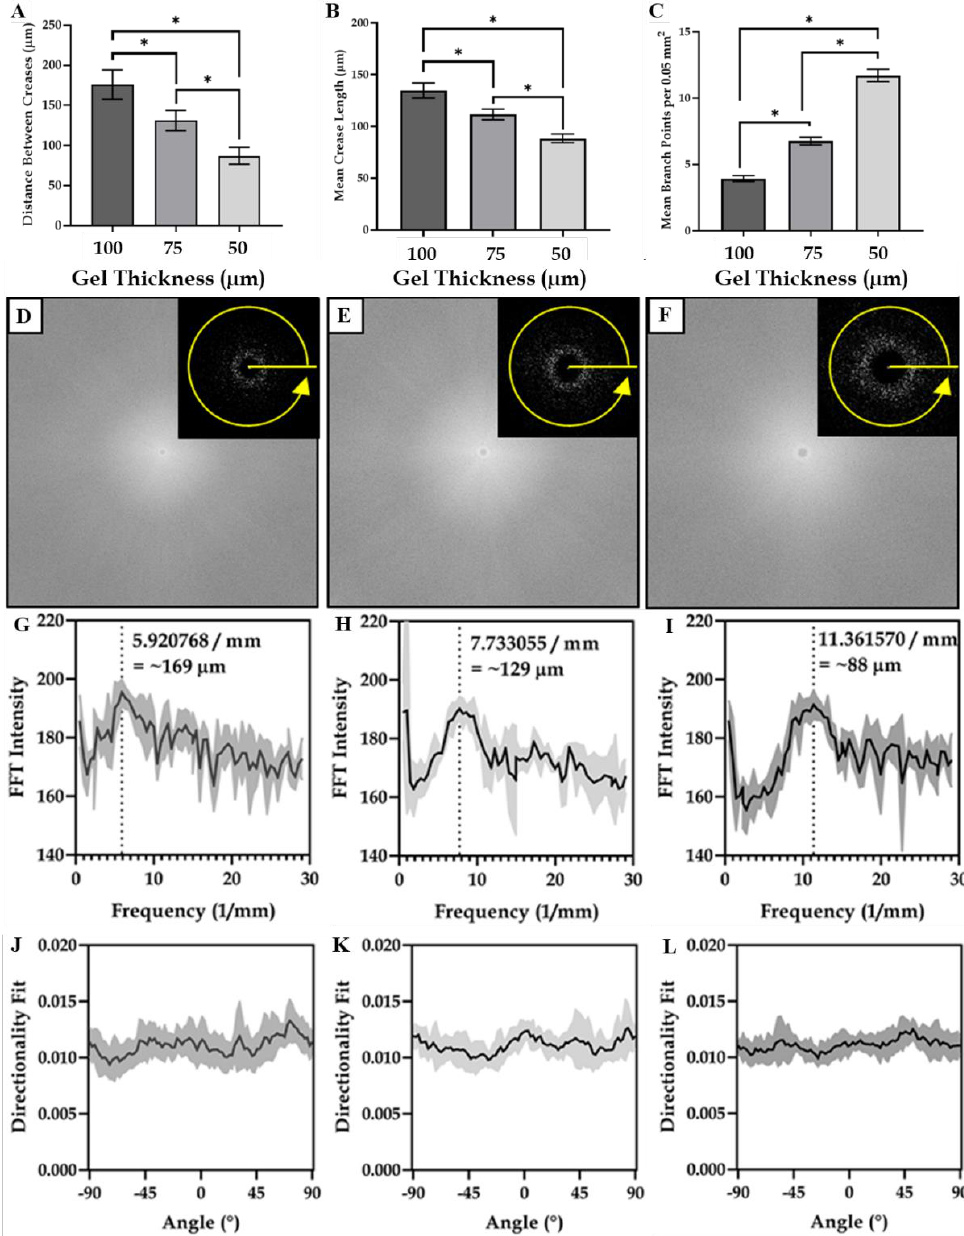
Figure 2. Regulation of hydrogel topography via gel thickness. ( A ) The average distance between surface creases plotted as a function of gel thickness (* indicates p < 0.05); ( B ) the mean length of the surface creases as a function of topography type; ( C ) the mean branch points of the surface creases per 0.05 mm 2 as a function of topography type; 2D-FFTs for ( D ) ~100, ( E ) ~75 and ( F ) ~50 μm gel thickness; FFT intensity for ( G ) ~100, ( H ) ~75 and ( I ) ~50 μm gel thickness and the directionality fit for ( J ) ~100, ( K ) ~75 and ( L ) ~50 μm gel thickness .